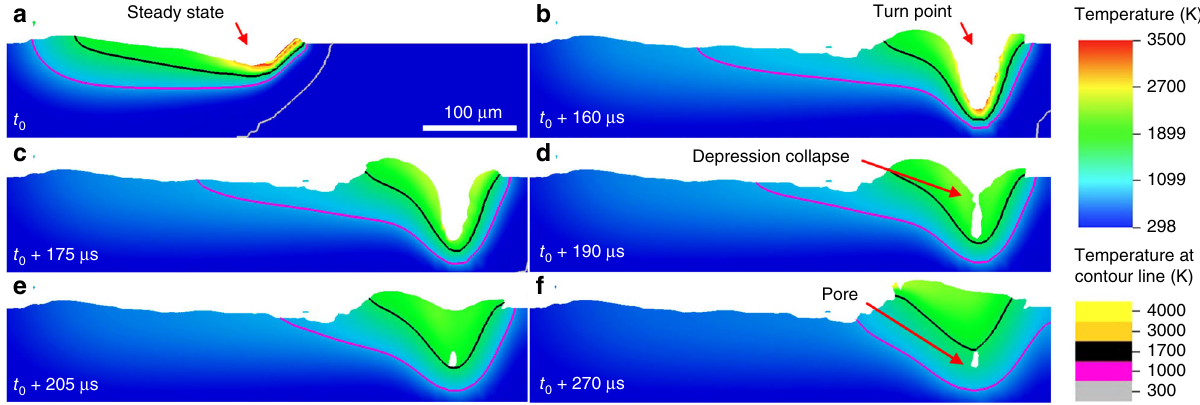
Fig. 5 Cross-section of multi-physics simulation of turn point dynamics in SS316L performed using ALE3D. The laser power was 200 W, and the steady- state scan speed is 1500 mm s − 1 and reduced during the turn point as per the physical system. The black contour line represents the melt pool